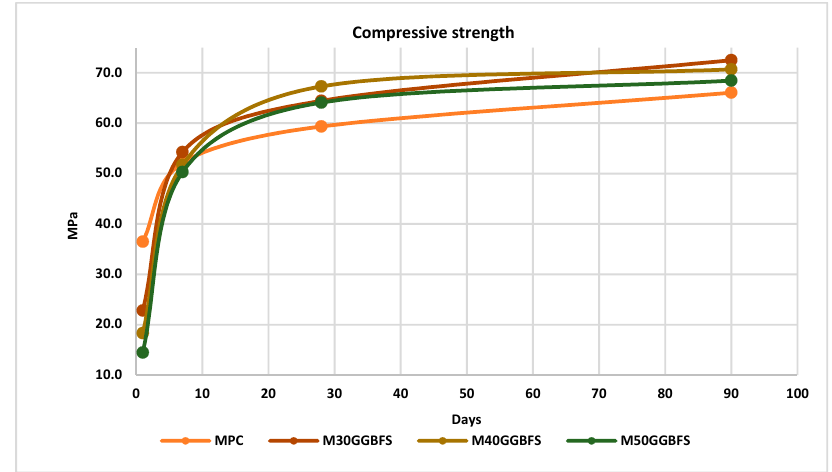
Figure 3. Compressive strength GGBFS.